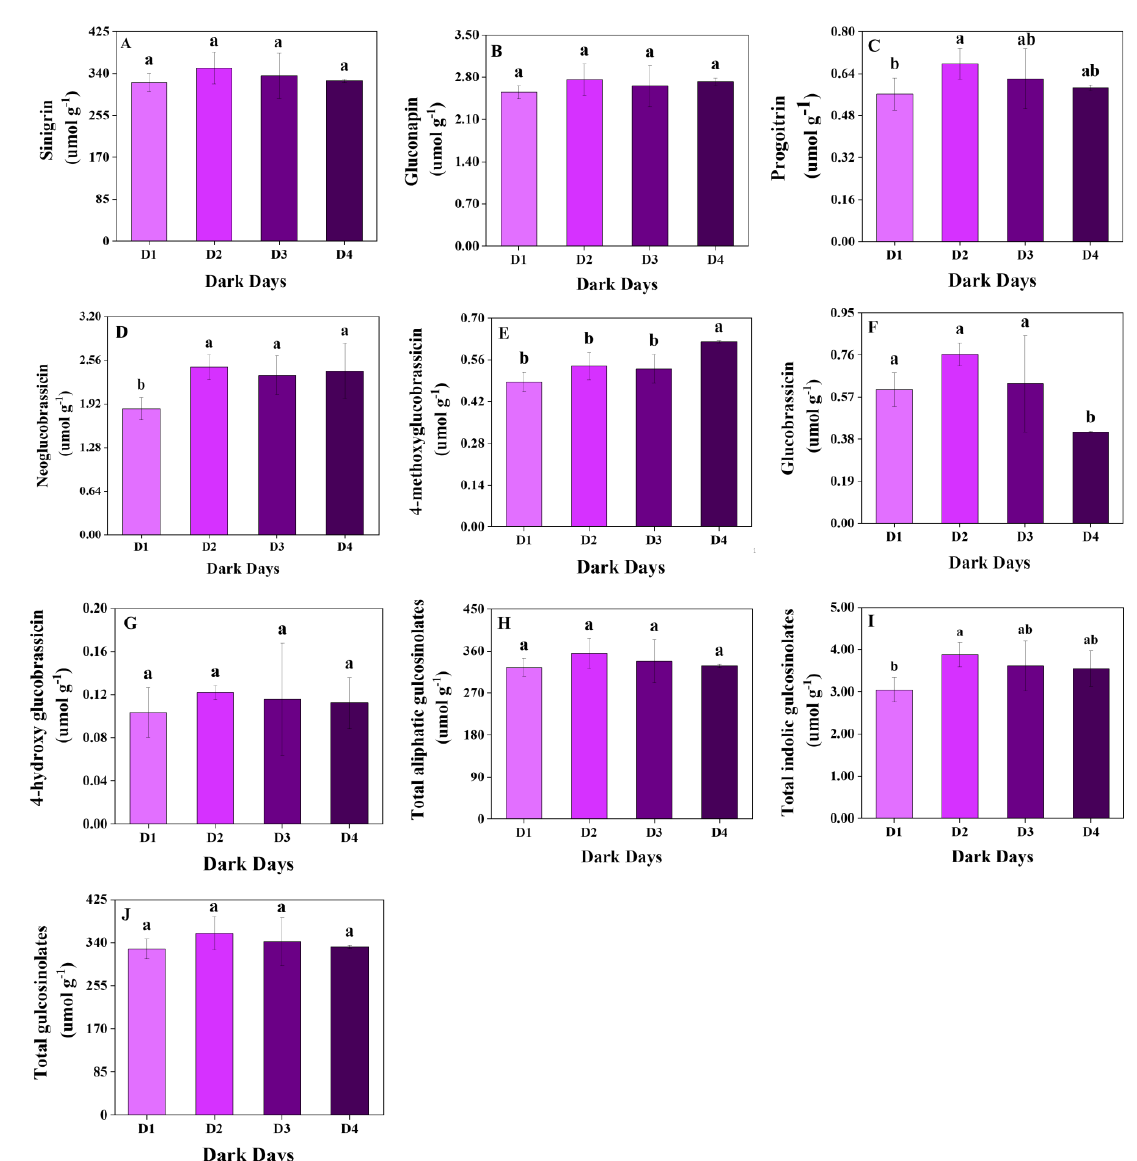
Figure 1. Glucosinolate content under different days of dark treatment in mustard sprouts. Data are expressed as mean ± standard deviation. The same letter in the same figure means no significant dif- ferences among values ( p < 0.05) according to the LSD’s test. ( A ) sinigrin; ( B ) gluconapin; ( C ) progoitrin; ( D ) neoglucobrassicin; ( E ) 4-methoxyglucobrassicin; ( F ) glucobrassicin; ( G ) 4-hydroxyglucobrassicin; ( H ) total aliphatic glucosinolates; ( I ) total indolic glucosinolates; ( J ) total glucosinolates. D1: dark treatment for one day; D2: dark treatment for two days; D3: dark treatment for three days; D4: dark treatment for four